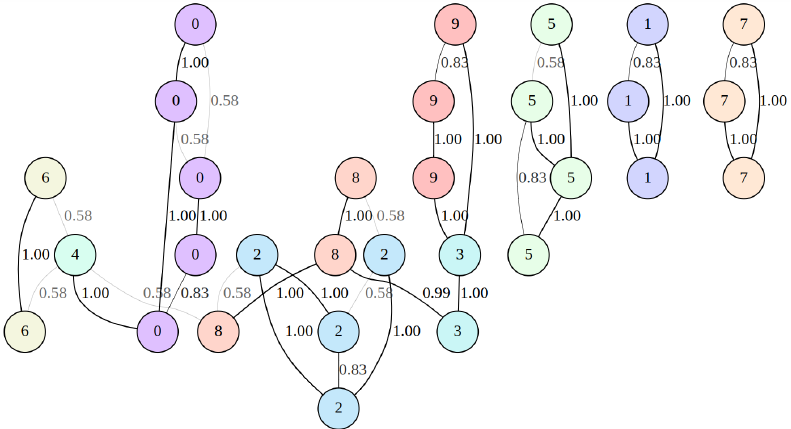
Figure 3. Graph represented by the weighted adjacency matrix M ∈ R 30 × 30 that was built by the UMAP algorithm for 30 randomly chosen images from the [30] dataset with neighbors count k set to 2. The visualization was obtained using the graphviz tool